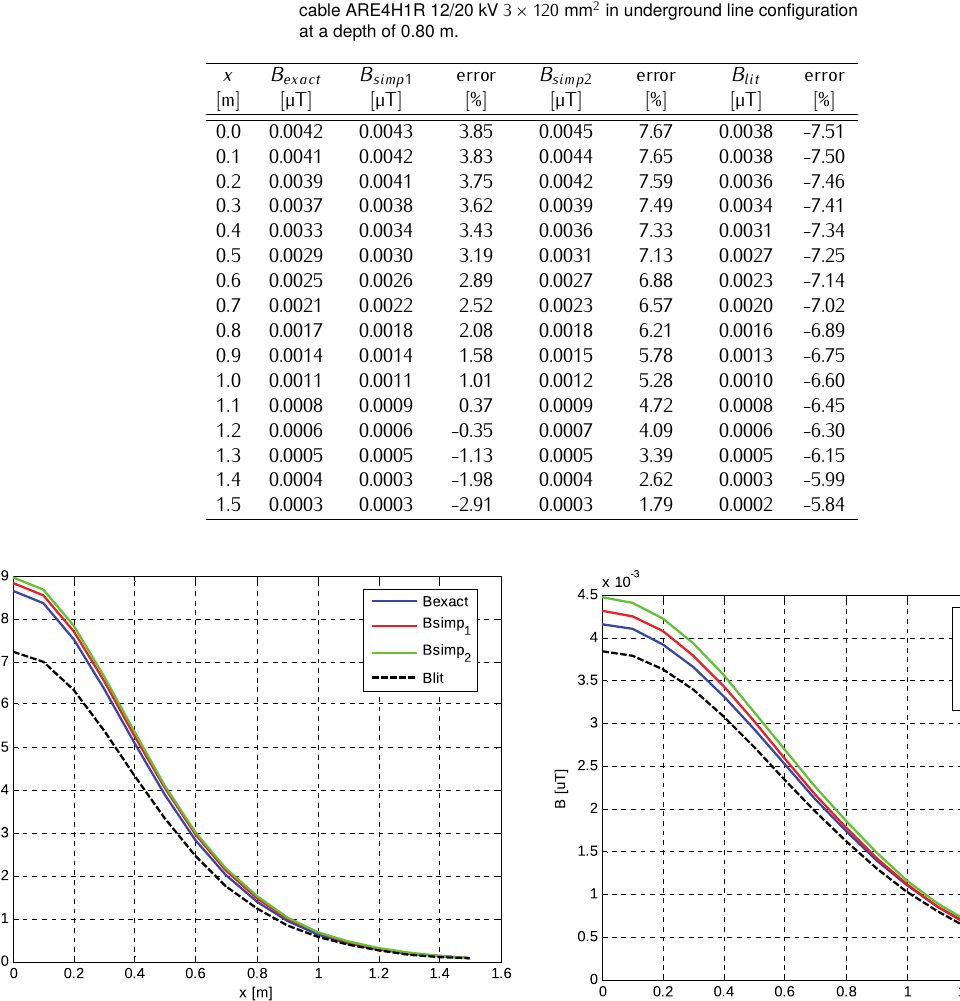
Table 3. B exact , B simp 1 , B simp 2 , B lit at 1 m height from the ground vs. distance x from the cable axis and relevant percent errors with respect to B exact for the